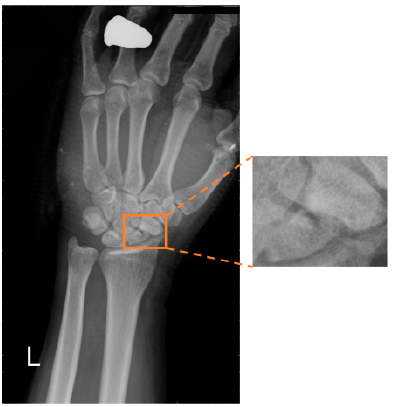
Figure 1. Example of the scaphoid bone.